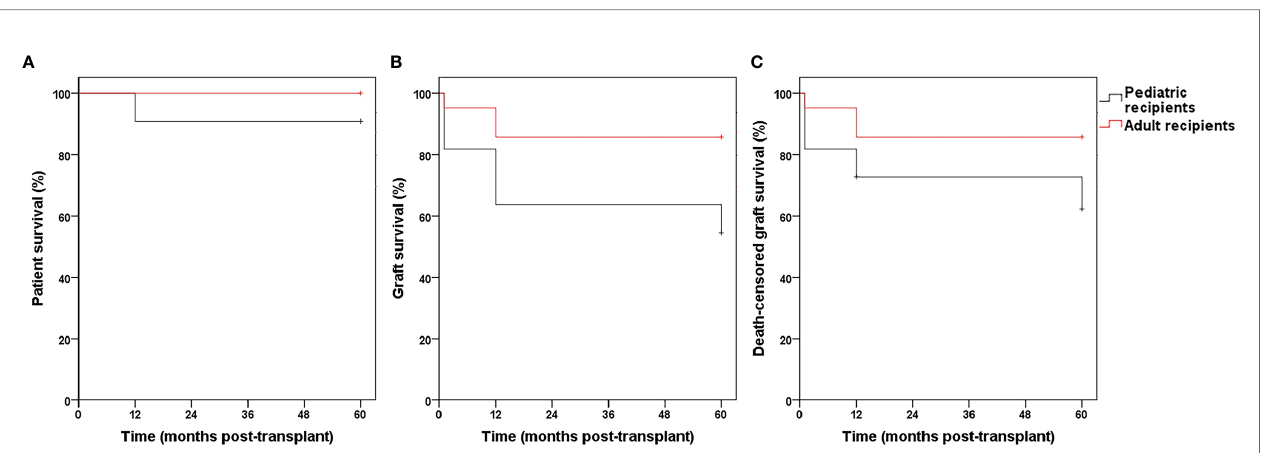
FIGURE 5 | The patient survival ( A , P > 0.05), graft survival ( B , P > 0.05) and death-censored graft survival ( C , P > 0.05) rates in Group pediatric recipients and adult recipients.